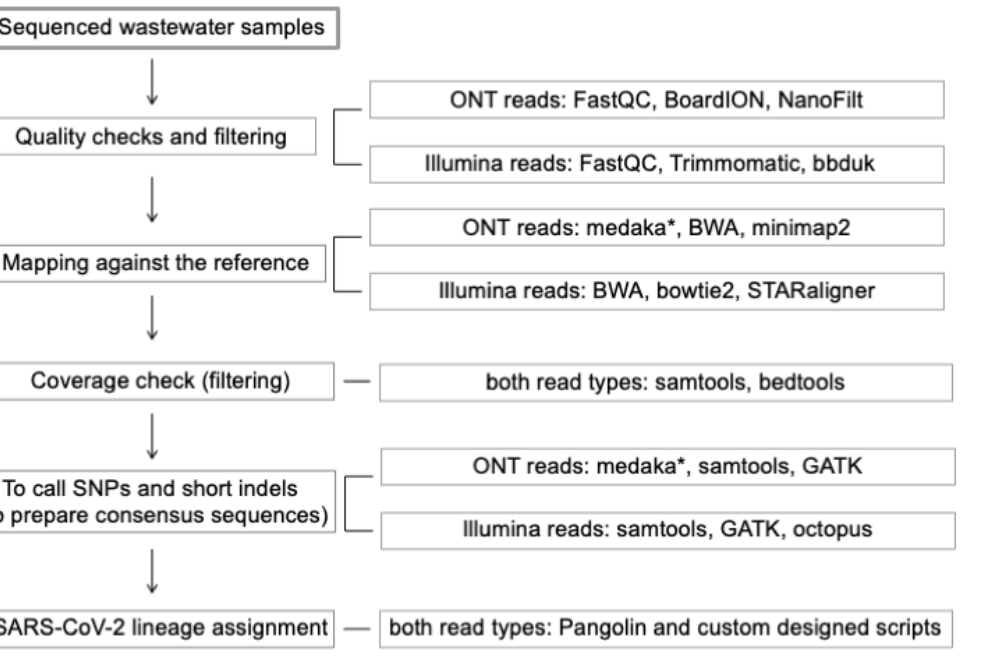
Figure 2. Scheme describing the data analysis and variant identification pipeline, with examples of frequently used tools.